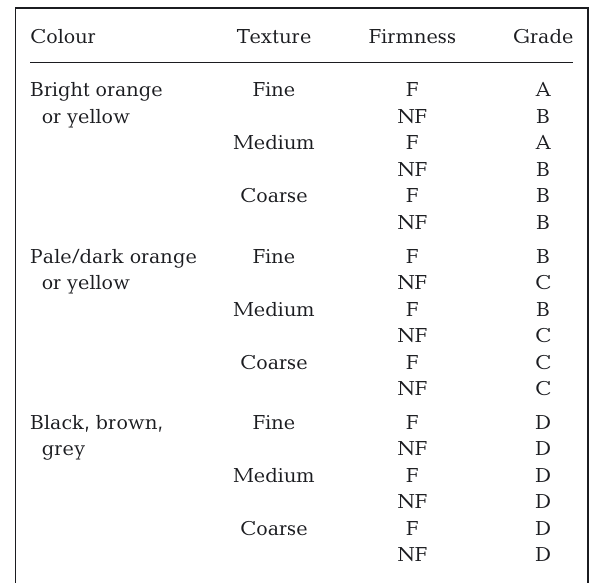
Table 2. Expt 2: grading system used to assess the com - mercial quality of Heliocidaris erythrogramma roe based on colour, texture and firmness. A-grade: premium quality; B- grade: high quality; C-grade: mediocre quality; D-grade: